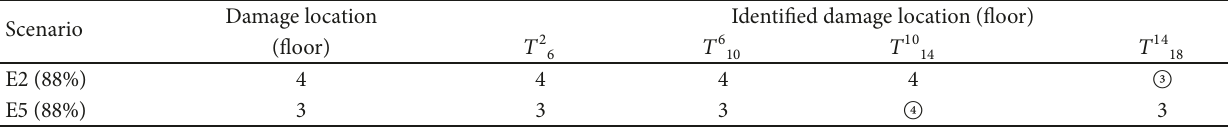
Table 12: Identified damage locations based on PC and SVM.